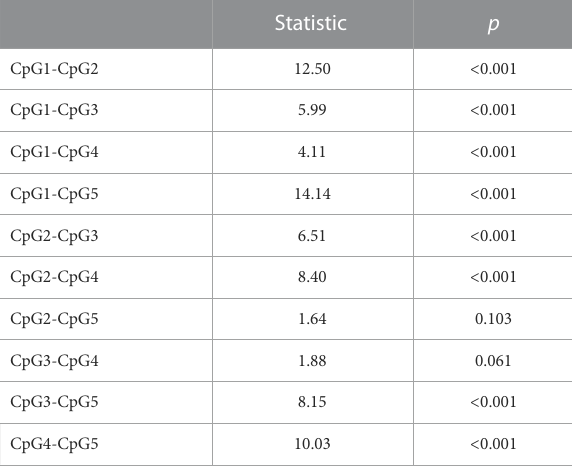
TYGGGYGGGTYGTYGYGGGAGAGGTGAGAG-3 ′ . Pyrosequencing measured DNA methylation levels of fi ve CpG sites indicated in Figure 1. DNA methylation analysis was performed using the PyroMark Q24 Advanced 3.0.0